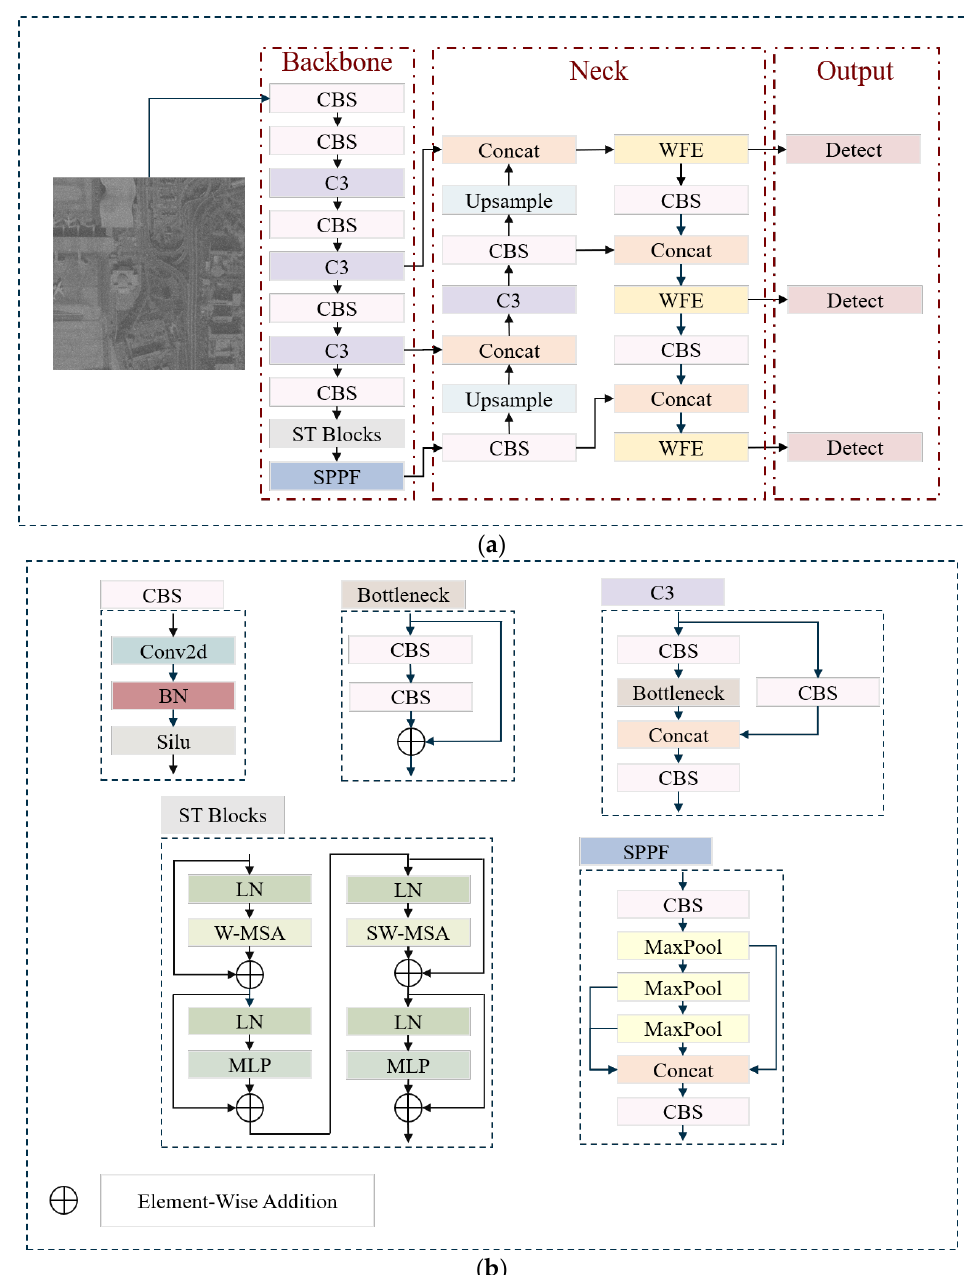
Figure 2. Overall architecture of the proposed method. ( a ) Composition of the L-SNR-YOLO network. ( b ) Modules used in the L-SNR-YOLO network.